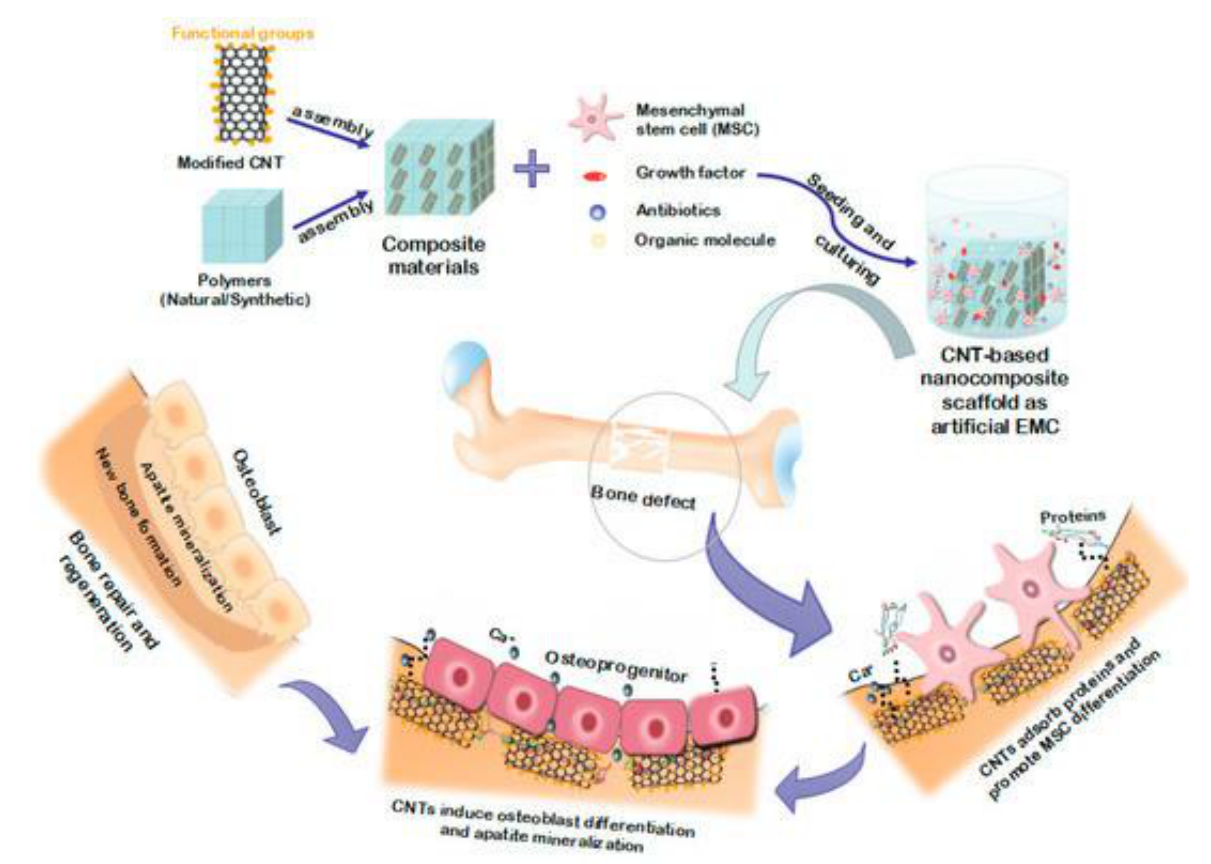
Figure 9. Describes the process of fabricating tissue scaffold and its role in tissue regeneration. Reproduced with permission from